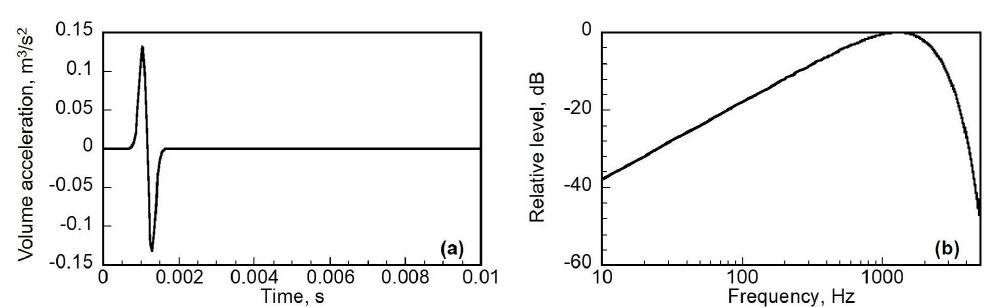
Figure 3. Modulated Gaussian pulse with upper-limit frequency of 2.5 kHz: ( a ) waveform and ( b ) frequency characteristics.